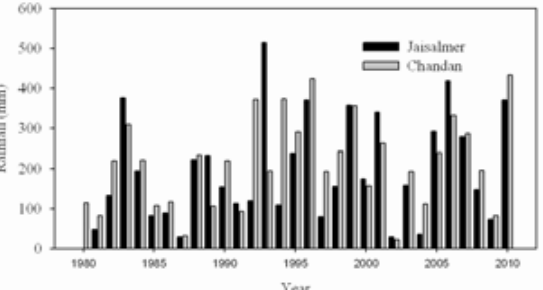
Figure 2. variation of annual rainfall at Jaisalmer and Chandan station in Jaisalmer district of western